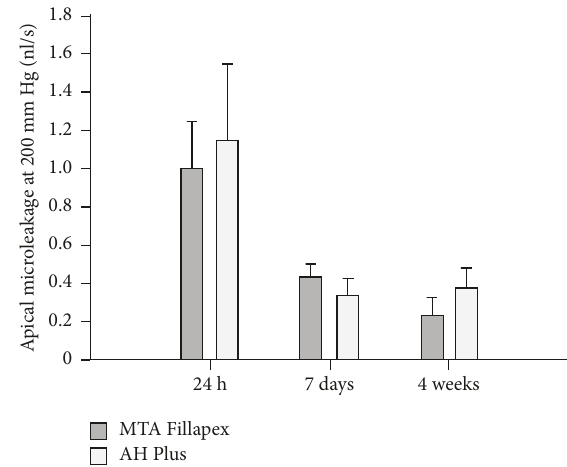
Figure 1: A bar chart of the mean apical microleakage mea- surements for both trial groups after 1 day, 1 week, and 4 weeks. The error bars demonstrate standard deviation from the mean value